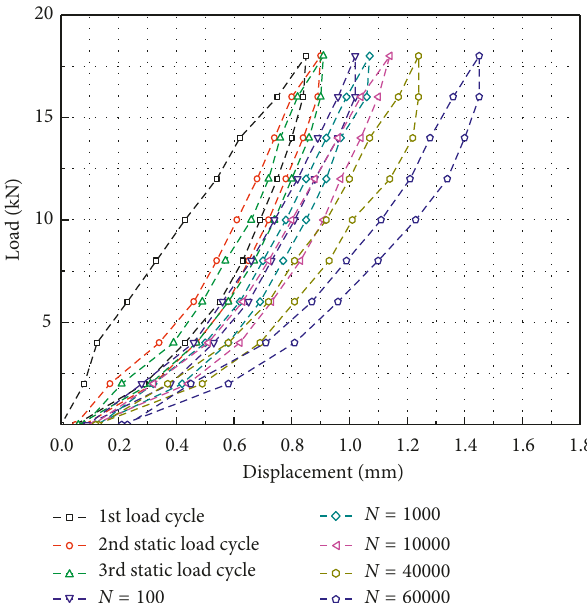
Figure 5: Load-displacement curves for specimen D20-F.